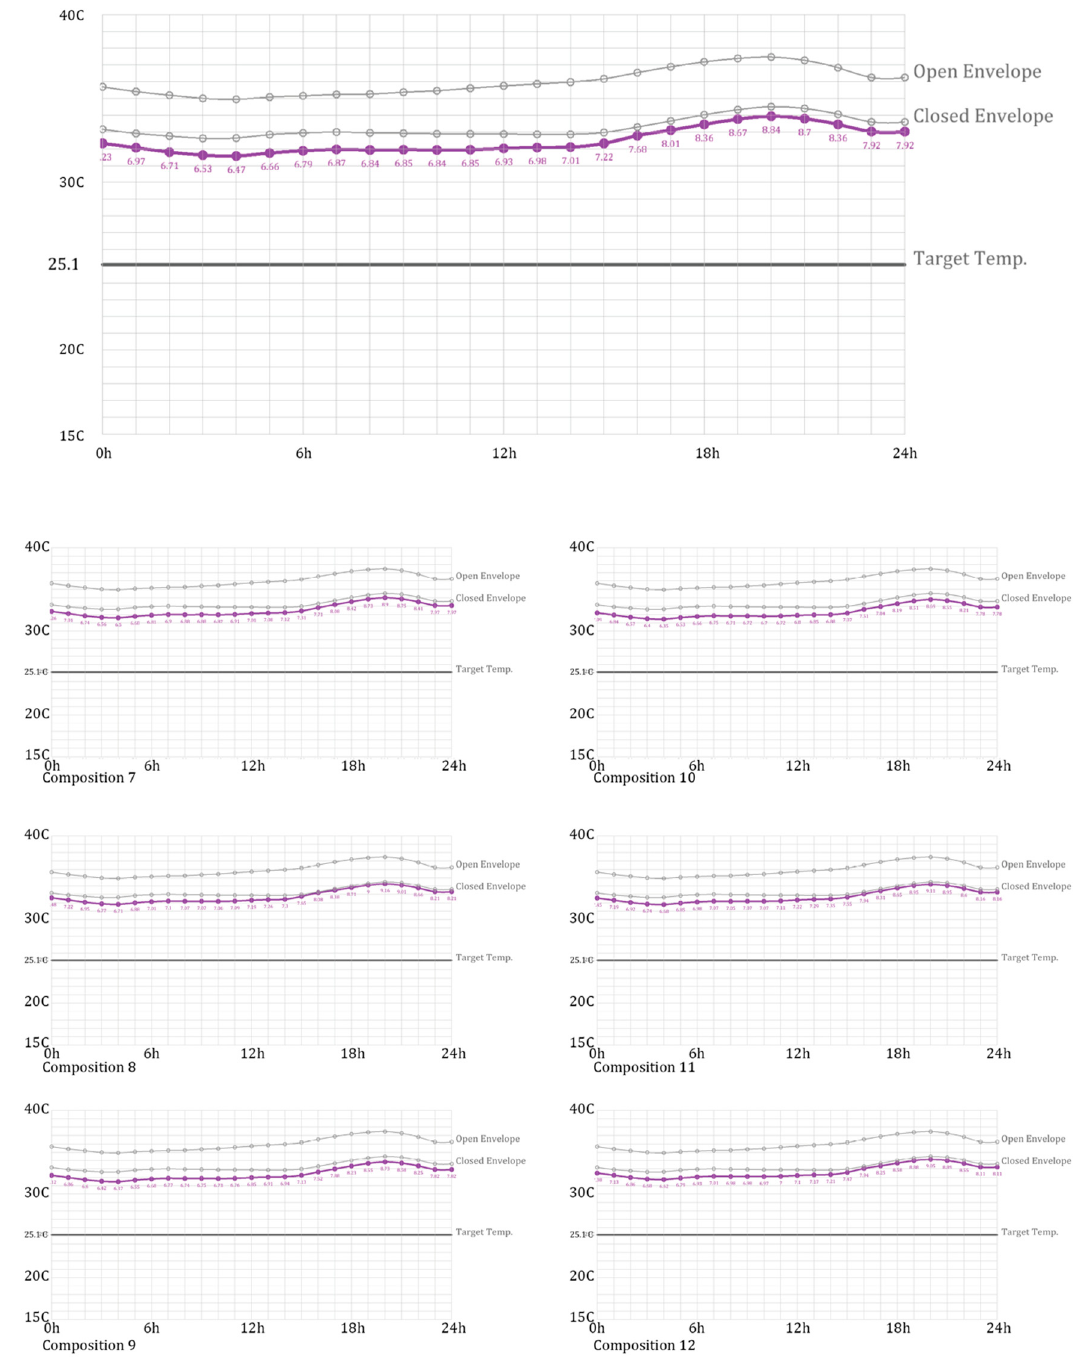
Figure 5. Temperature graphs of temperature deviation for computed compositions 6–12 on 21 June. Related design compositions can be seen in Figure 4.